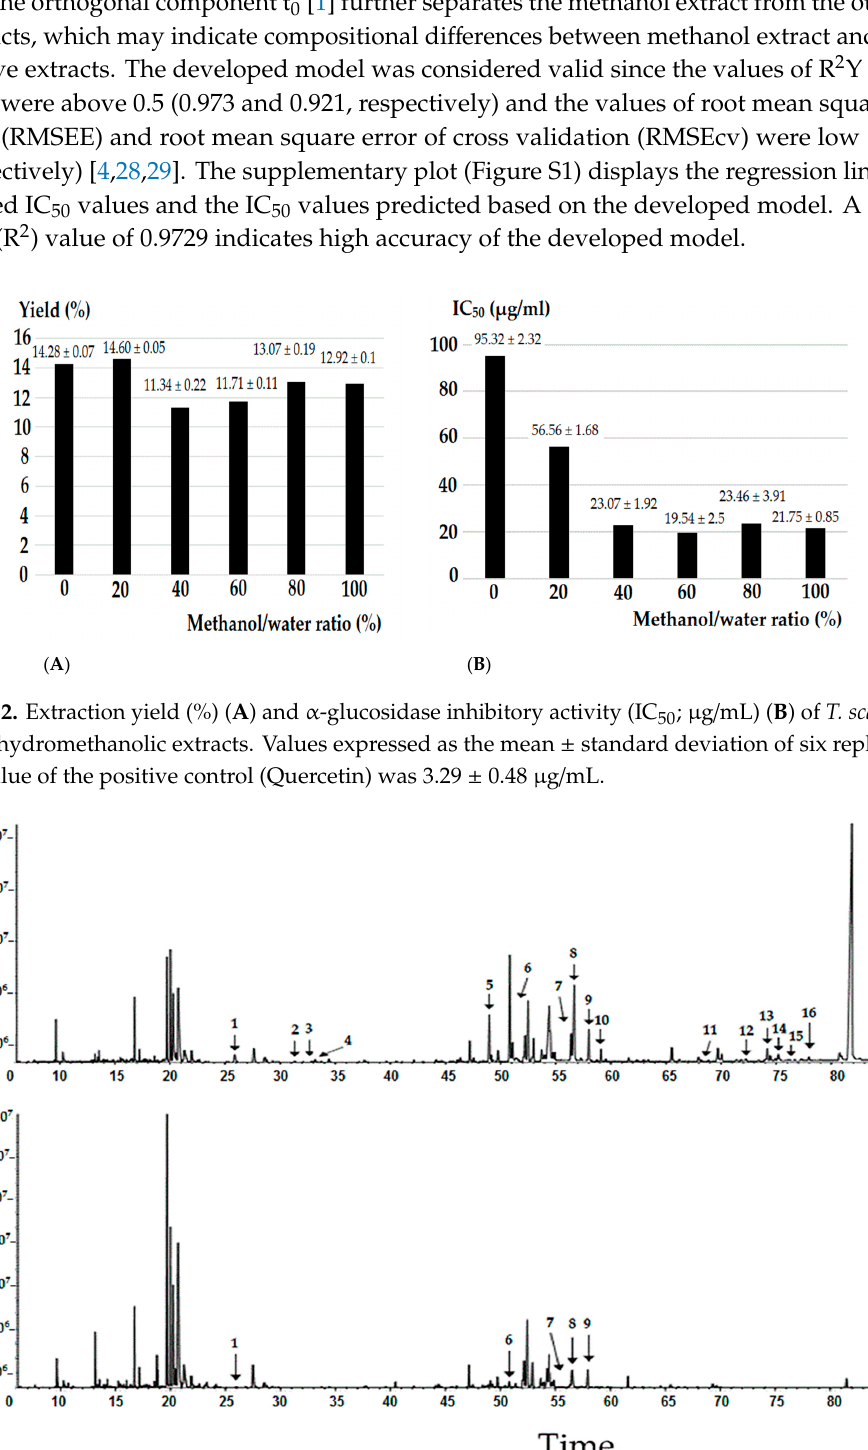
( B ) Figure 4. ( A ) Scores scatter plot of the established orthogonal partial least squares (OPLS) model for T. scandens leaves extracts, showing the highly active extracts on the negative side of the predictive component t[1], while the less active extracts on its positive side. ( B ) Loading column plot of the developed OPLS model.